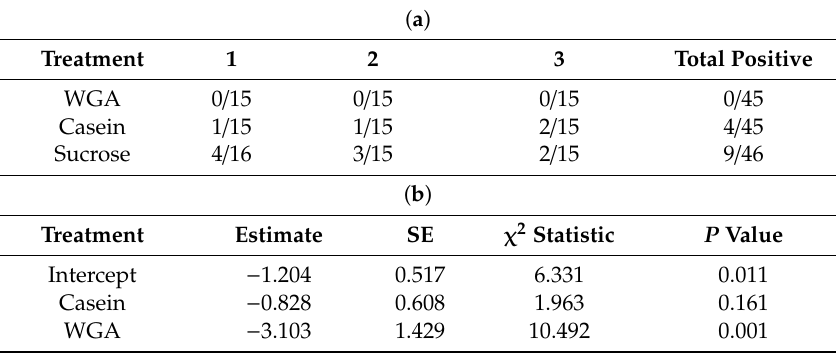
Table 3. GLRaV-3-transmission is reduced by a lectin. ( a ) Results from three biologic replicates of GLRaV-3 blocking transmission tests showing the number of plants infected / plants inoculated. ( b ) Statistical results from bias-corrected logistic regression testing di ff erences between wheat germ agglutinin (WGA) and casein transmission results from sucrose